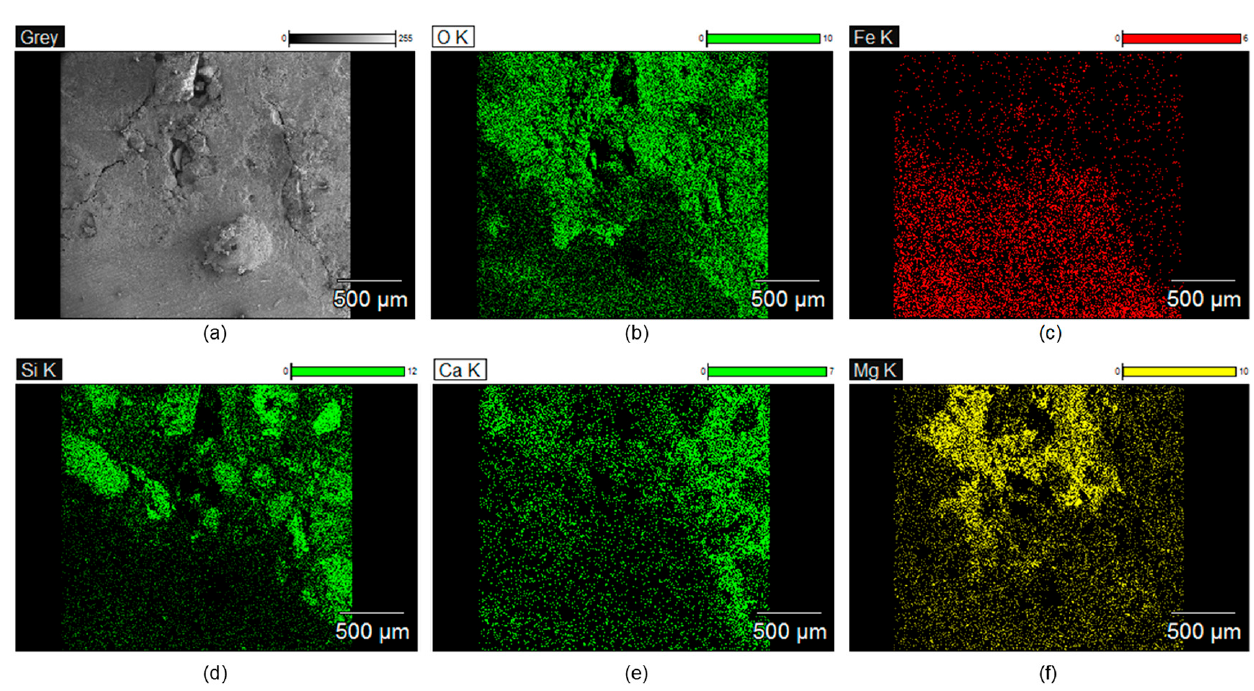
Figure 13. SEM/EDAX image of the cross-section of the concrete sample TP3-3 at the tip of a surface-breaking crack after EDT process: ( a ) SEM image, ( b ) distribution of primary elements in the regions 1 and 2 in the SEM image shown in Figure 13a.